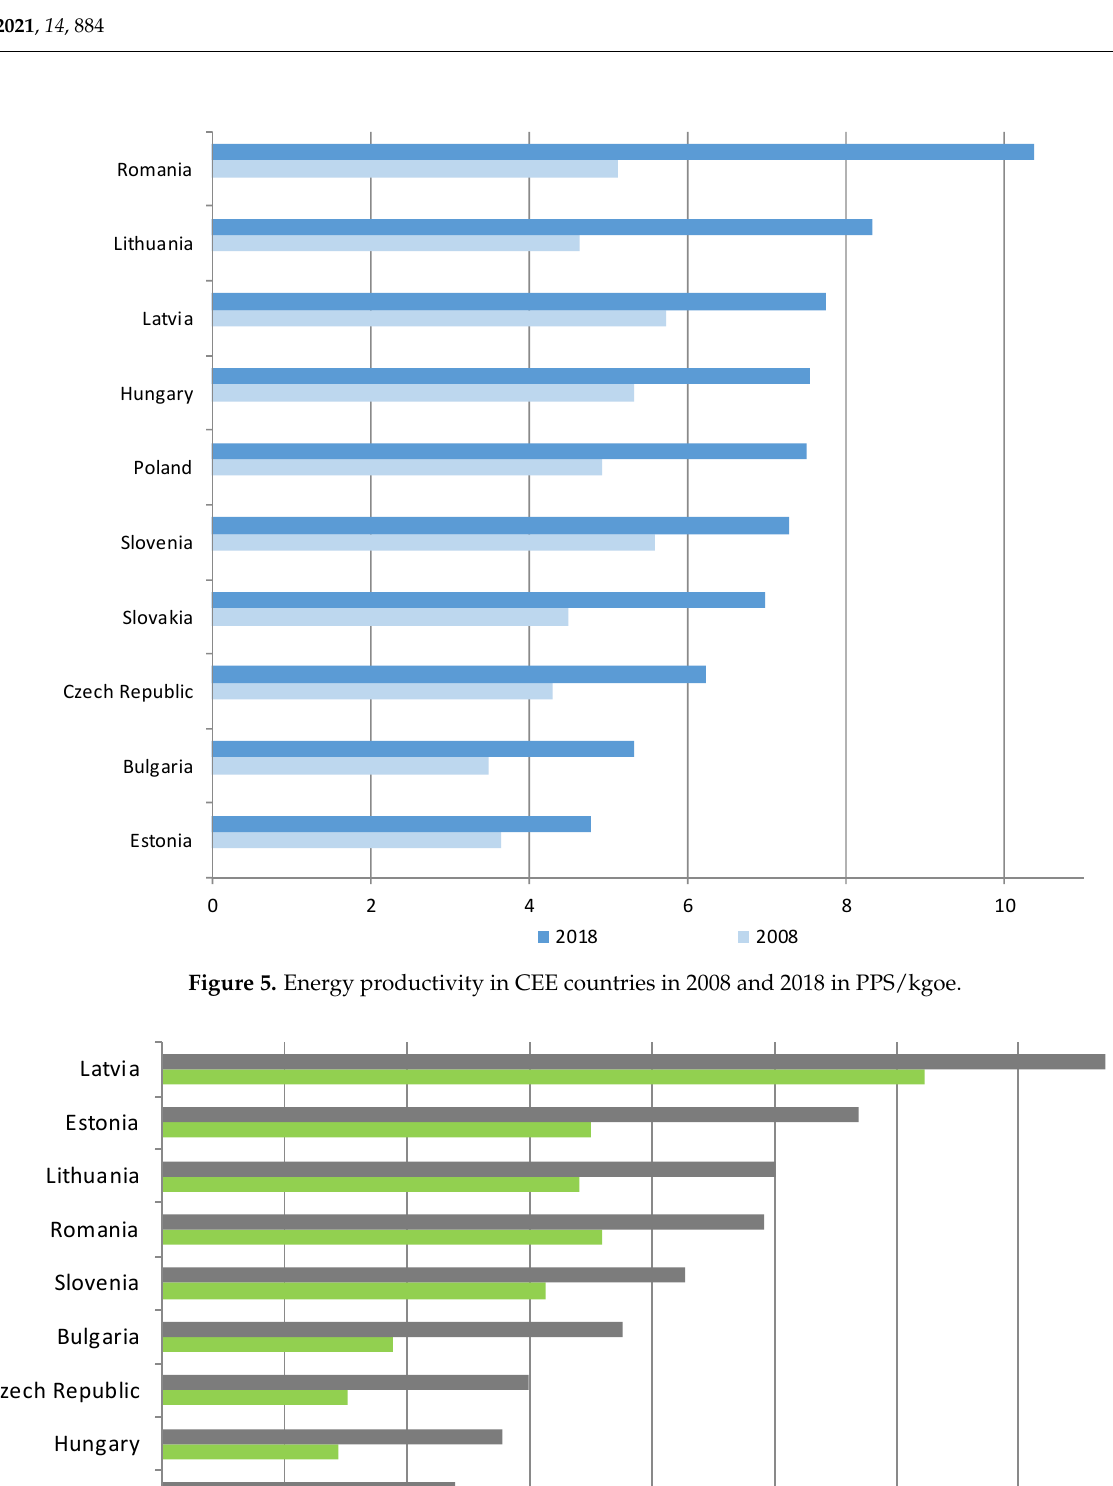
role in Poland, Slovakia, and Hungary (from 11.4 to 13.9%).